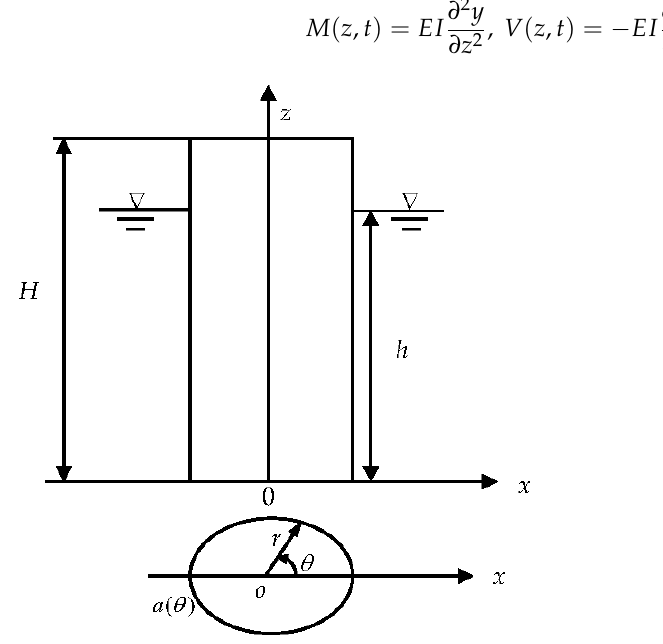
Figure 1. The cylinder with a non-circular cross-section partially submerged in water.